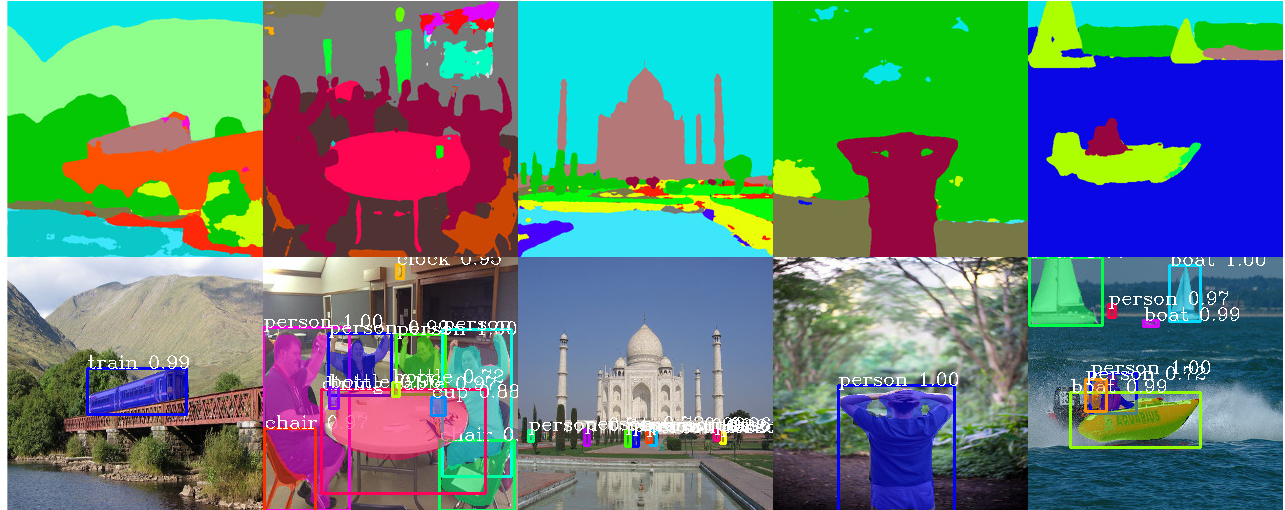
Figure 2. Examples of Multi-label Semantic Recognition. Targets and scenes in images are displayed in different colors, and targets with a confidence ≥ 0.7 are also